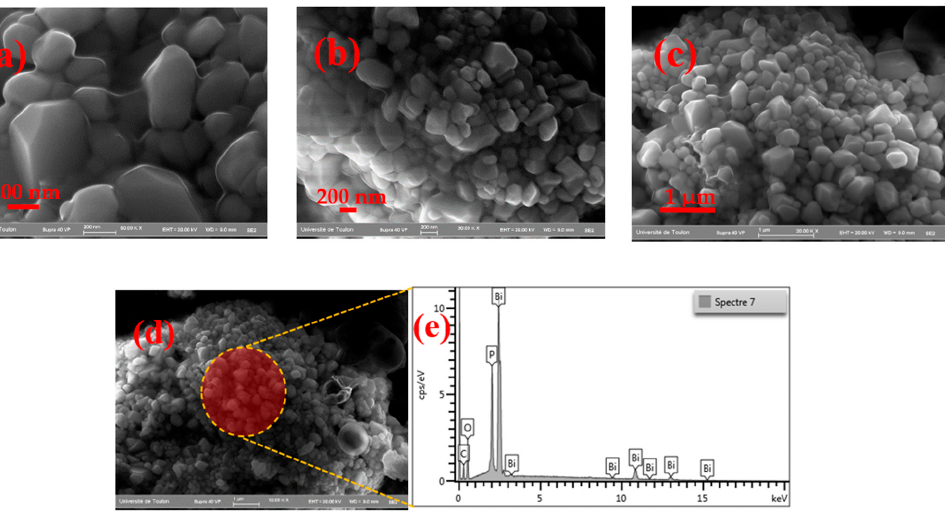
Figure 3. SEM images and EDX spectrum of BiPO 4 treated at 500 °C.